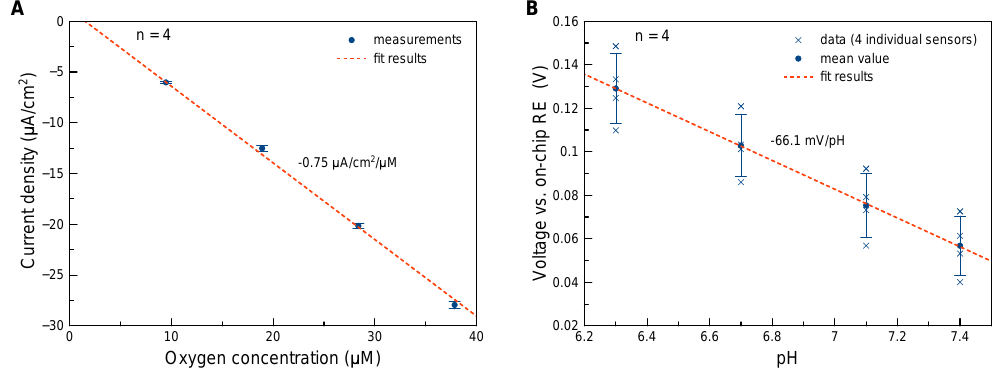
Figure 4. Calibration plot oxygen sensor ( A ): Sensors were calibrated at 37 ◦ C in cell culture medium equilibrated to different oxygen content and 5% CO 2 in the gas phase. Error bars represent the standard deviation of measurements from four individual electrodes fabricated in the same batch, calibration plot pH sensor ( B ): Sensors were calibrated after sterilization in buffer solution at 25 ◦ C. Both mean value and data points from four individual electrodes were plotted. Please note that the large error bars (standard deviation) are caused by variation of the offset rather than of the